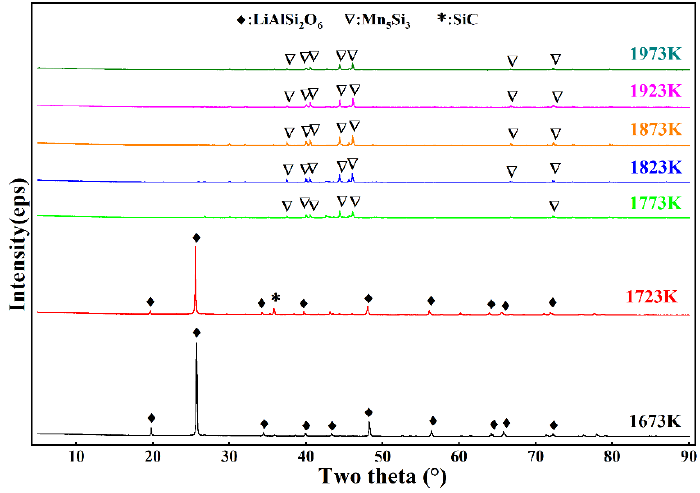
Figure 5. XRD patterns of the underlying material at varying reduction temperatures.